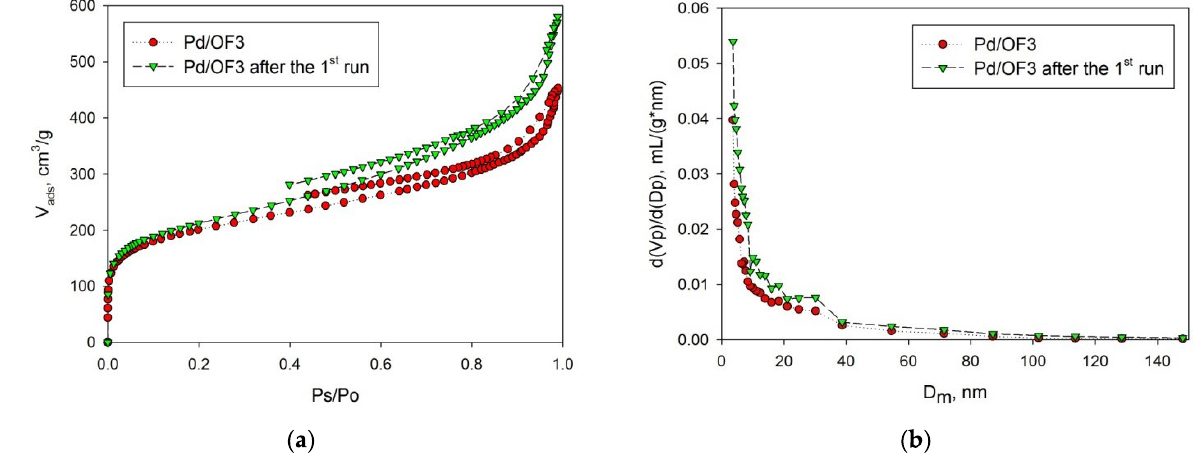
Figure 8. Comparison of adsorption–desorption isotherms ( a ) and pore-volume distributions ( b ) for Pd/OF3: initial and taken after the MBY